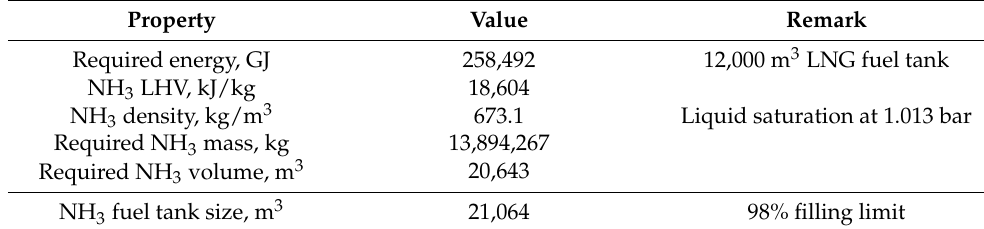
Table 6. NH 3 fuel tank sizing [28].